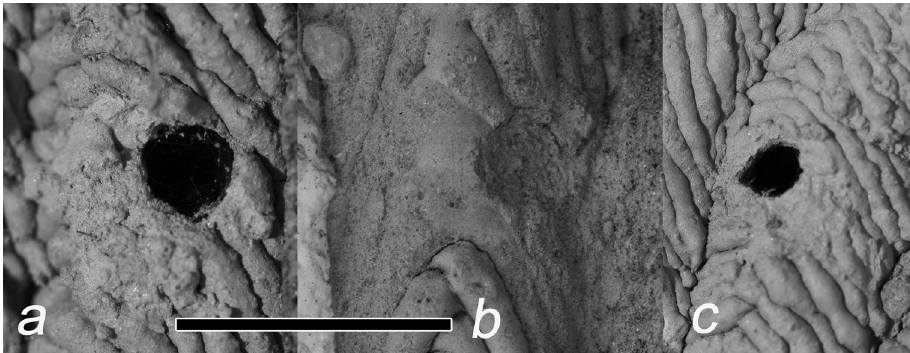
Figure 1. Stages in the reutilization of old Trypoxylon albitarse cells by T. nitidum . a Without reutili- zation (note T. albitarse emergence hole) b Reutilized with no emergence by T. nitidum (note closure without emergence hole) c Reutilized with emergence by T. nitidum (note smaller emergence hole). Scale bar = 1 cm. Figure by Terry